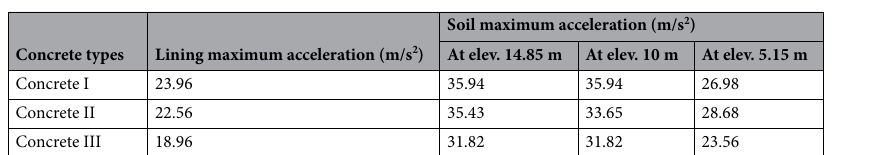
Table 5. Lining and soil maximum total acceleration for the three concrete models.